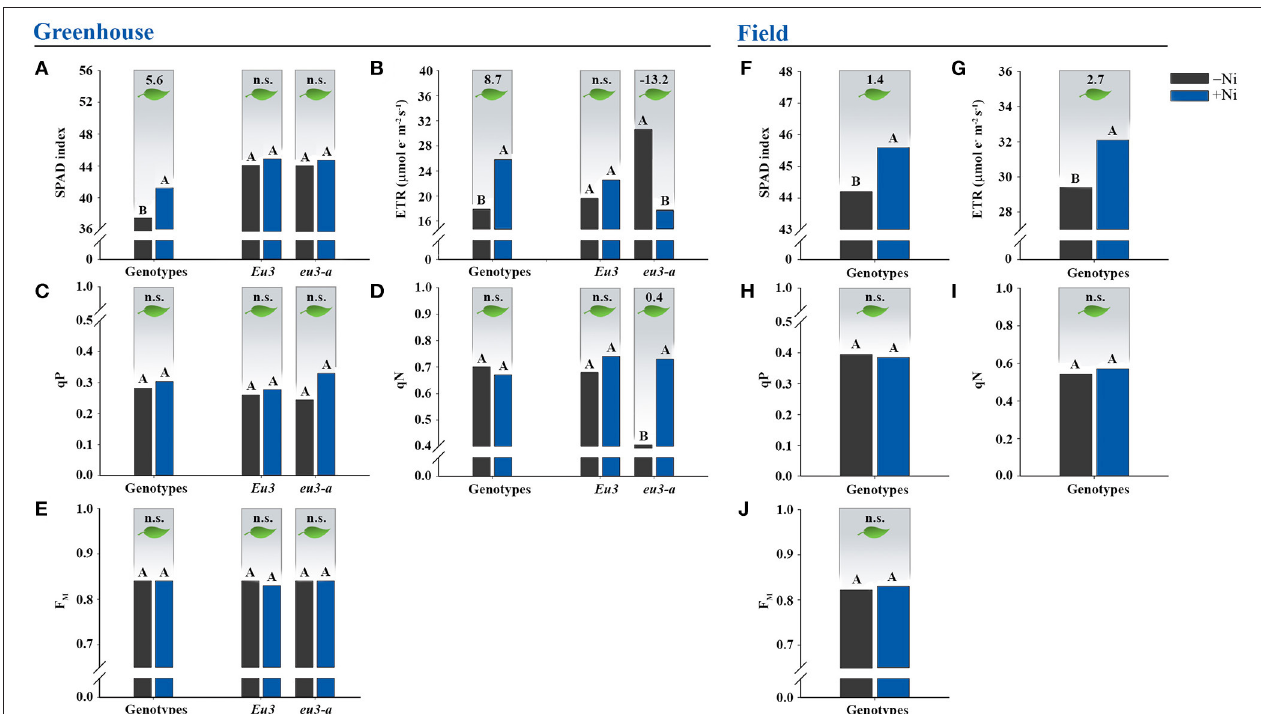
FIGURE 2 | Effects on leaf photosynthesis due to fertilization with 0.0mg of Ni kg − 1 ( − Ni) and 0.5mg of Ni kg − 1 ( + Ni) in 15 soybean genotypes and two near-isogenic lines (NILs), Eu3 and eu3-a , cultivated in (A–E) greenhouse condition and (F–J) field condition. Means were compared by the effect of the Ni doses in each genotype by Dunnett’s test at P < 0.05, and those followed by the same letter do not differ. In greenhouse, only the mean of Ni-dose effects in the genotypes were presented since interaction genotype x Ni dose was caused by NILs alone. Values indicated in the upper part of the figure correspond to the amplitude of difference between Ni doses in photosynthesis. n.s., not significant. ETR, electron transport rate. qP, photochemical quenching. qN, non-photochemical quenching. F M , maximum fluorescence. The NILs were not tested in the field experiment.